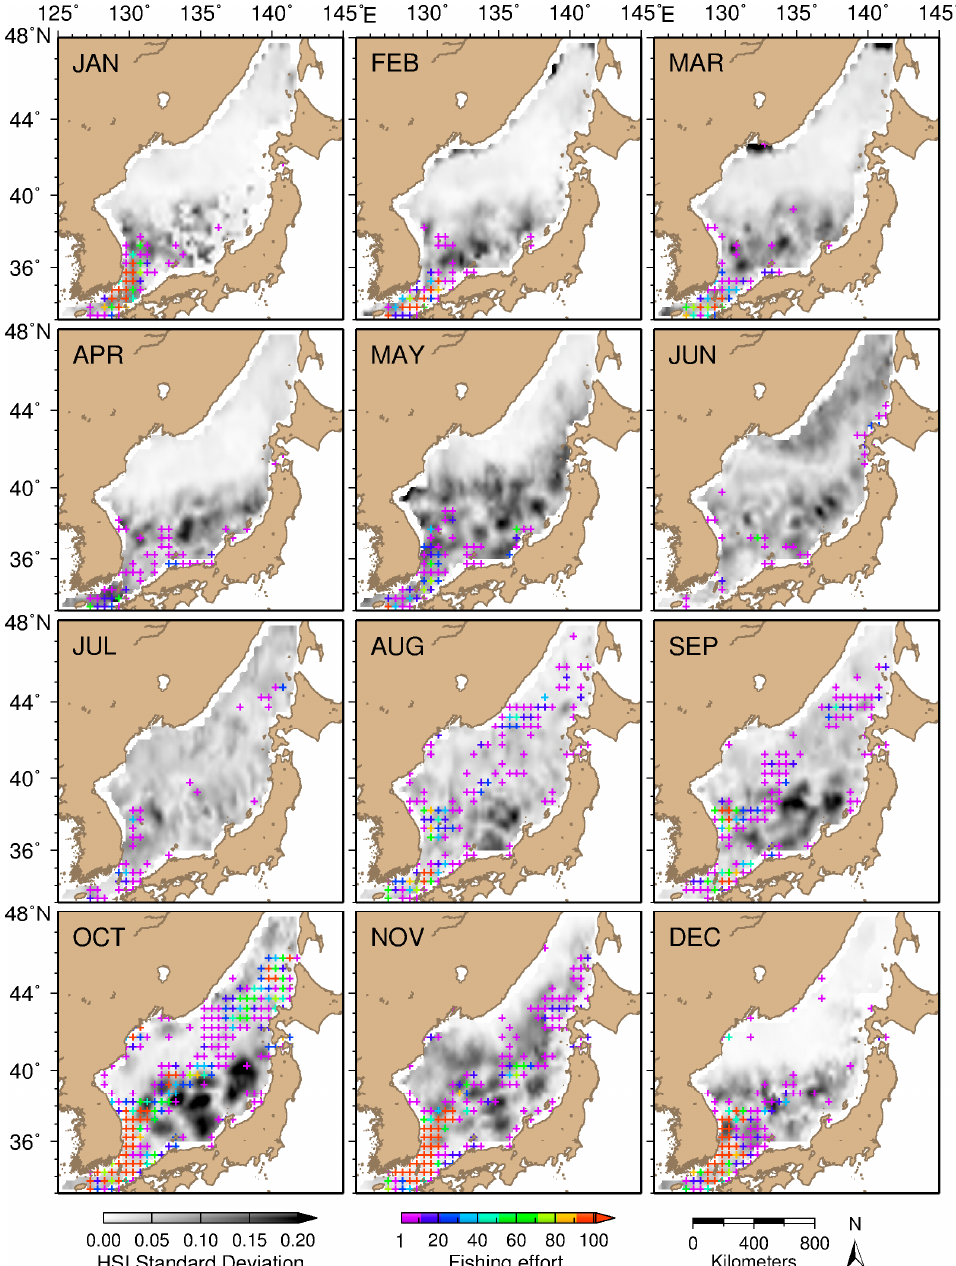
Figure 5. Monthly-averaged standard deviation of potential squid habitat in the Sea of Japan from multiple model simulations developed from January–December, 2010–2013. Overlain are the monthly gridded fishing efforts derived from night-time satellite images.